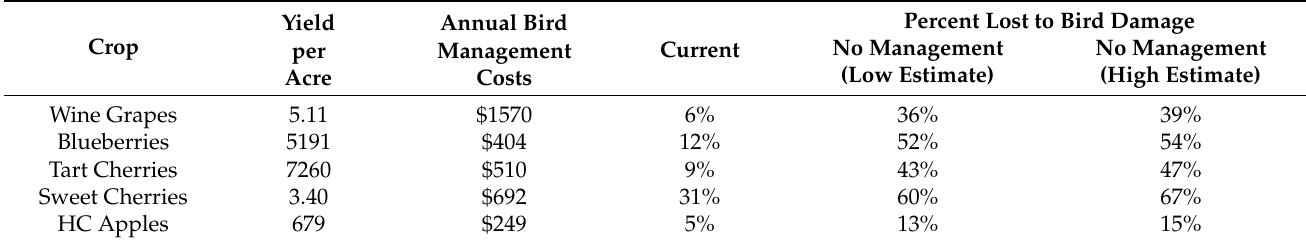
Table 4. Apples, cherries, and grapes losses linked to bird damage